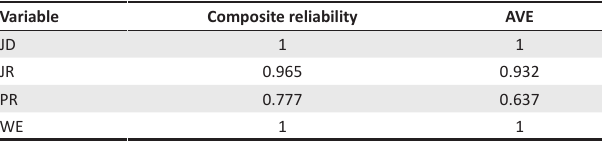
TABLE 3: Outer model (quality